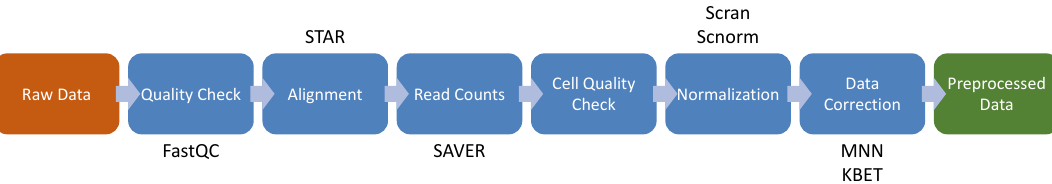
Figure 4. Data preprocessing schema for single-cell RNA-Seq. The brown box indicates the input of the pipeline. The green box indicates the output of the pipeline. The blue boxes show the intermediate steps of the pipeline and above or below the boxes are shown the software/packages employed in the